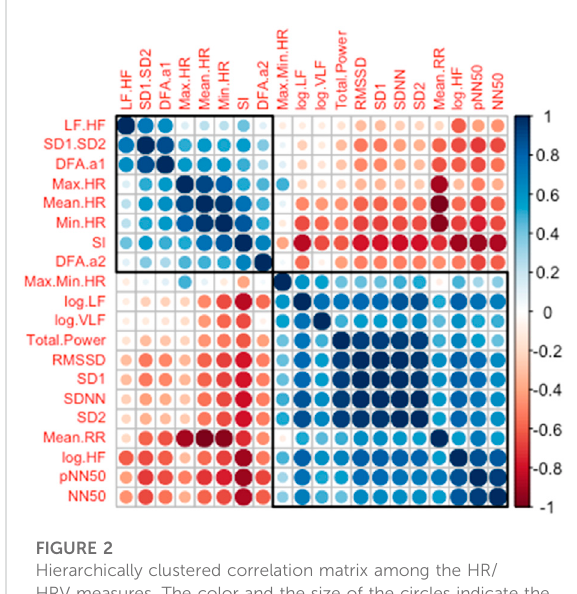
Hierarchically clustered correlation matrix among the HR/ HRV measures. The color and the size of the circles indicate the strengthofcorrelationwithblueshadesindicatingpositiveandred shades indicating negative correlations. The black squares on top-left and bottom-right show the grouping based on the similarity and dissimilarity of each variable roughly clustering into the PNS (bottom-right) and the SNS (top-left) groups. Abbreviations:LF.HF,Ratiooflowfrequency(LF)tohighfrequency (HF) band powers; SD1.SD2, Ratio of Poincaré Perpendicular Standard Deviation (SD1) to Poincaré Parallel Standard